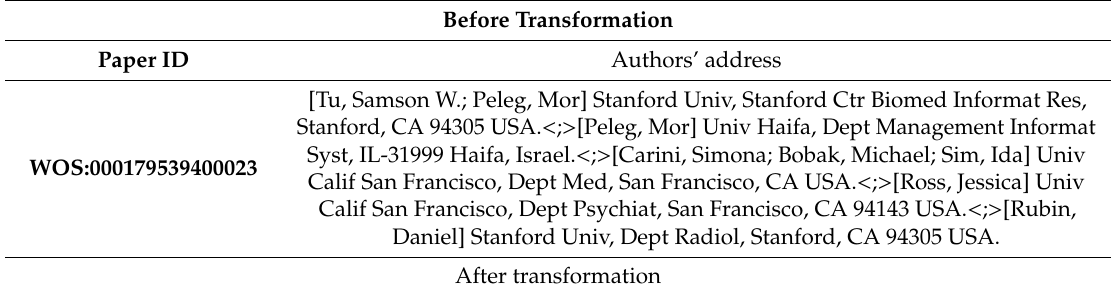
Table 4. Example of the authors’ addresses